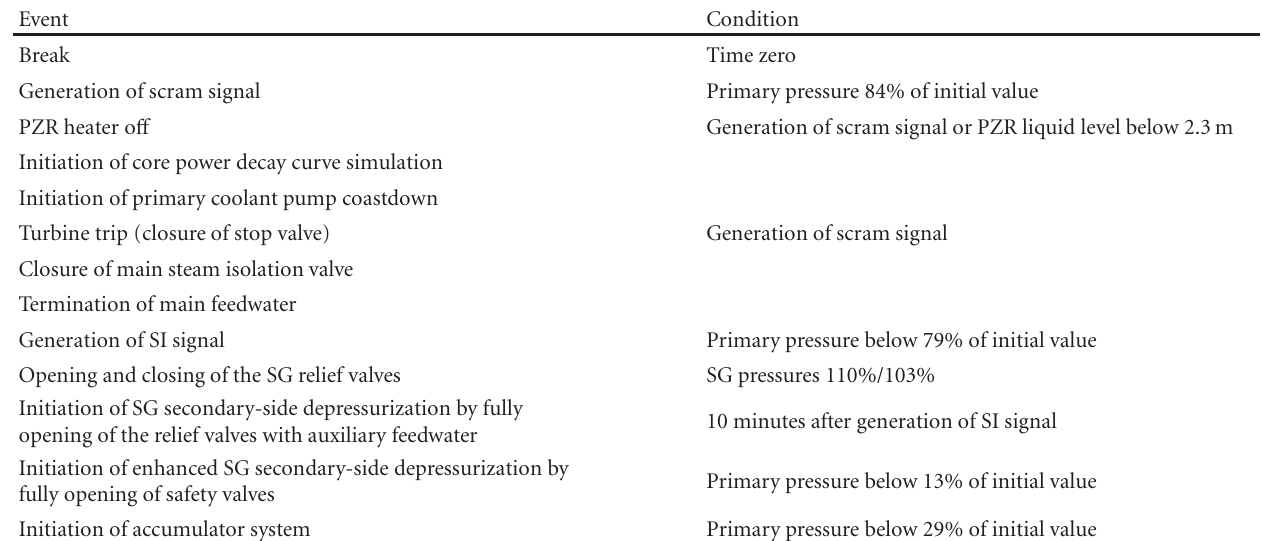
Table 10: Control logic of Test 5-2 [14].